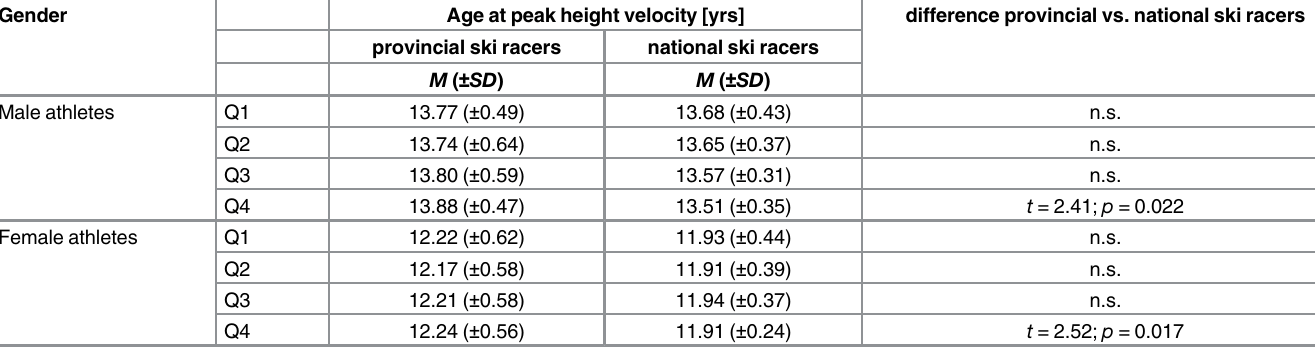
Table 4. Biological maturity status of provincial and national ski